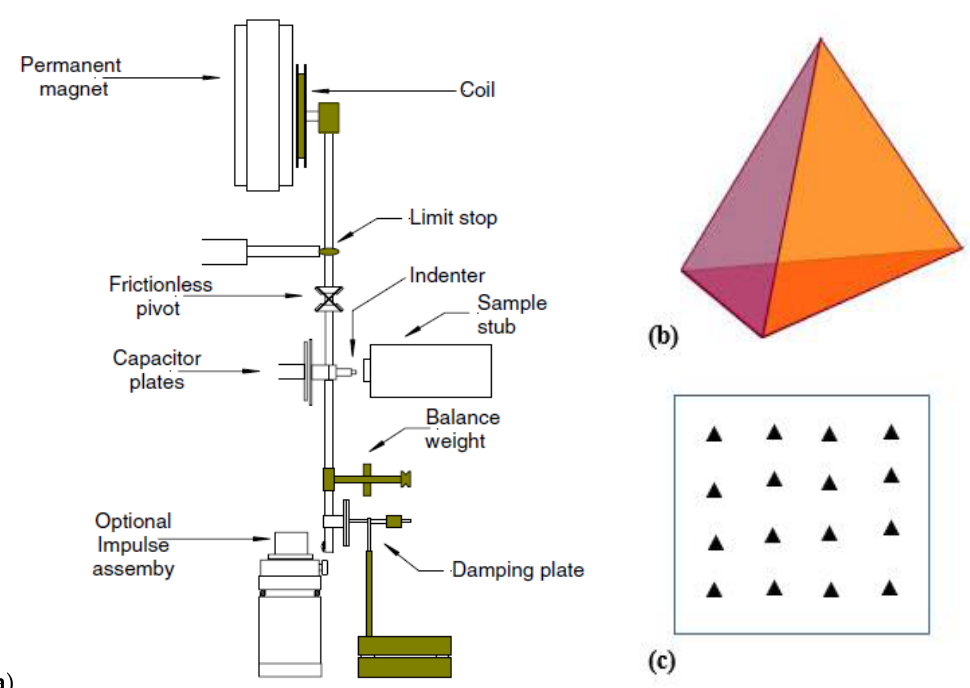
Figure 2. ( a ) Diagrammatic illustration of the nanoindentation test system, ( b ) a typical Berkovich indenter tip for nanoscale measurements and ( c ) symmetrical indentations at 30 µm apart (not to scale) on the HF/PCL biocomposite sample.